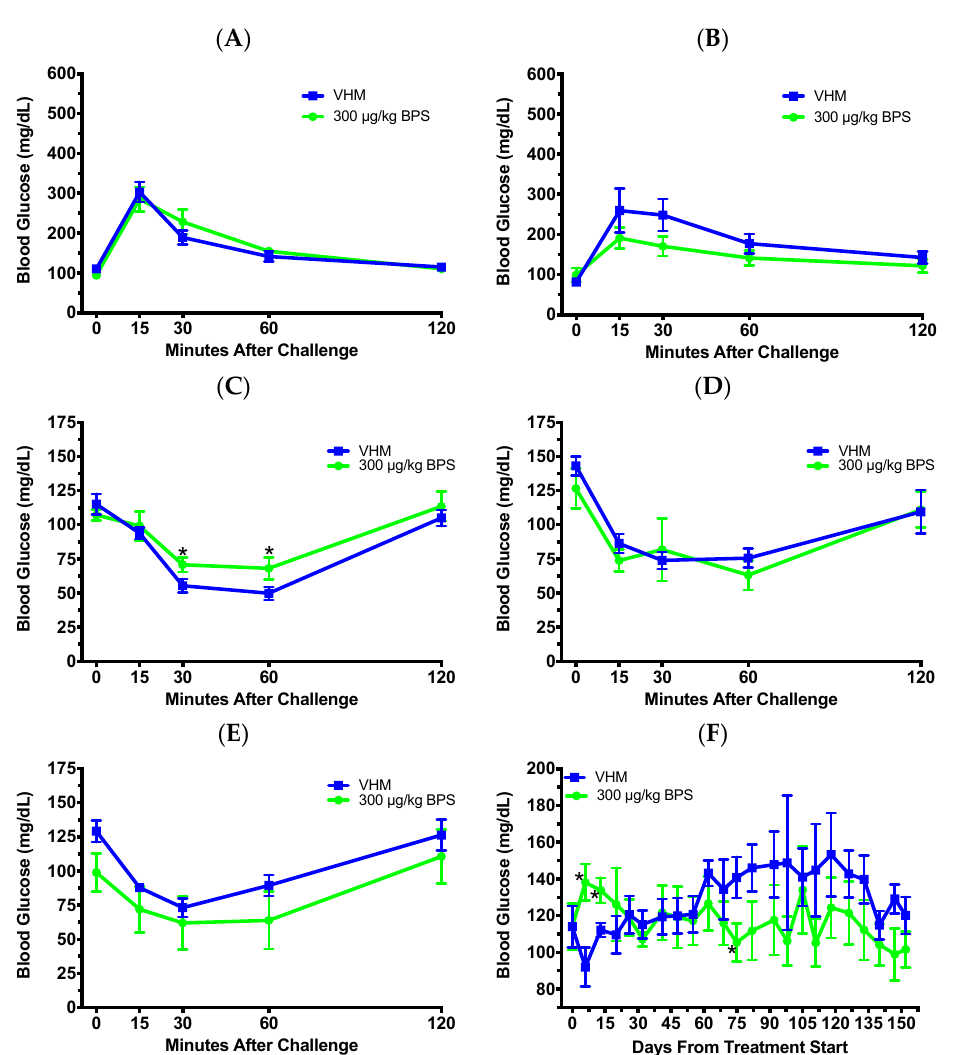
Figure 3. Tolerance tests and blood glucose levels (BGLs) in male NOD mice on the soy-based diet. GTT after 1 month ( A ) and 2 months ( B ) of BPS exposure, and ITT after 1 month ( C ), 2 months ( D ) and 5 months ( E ) of BPS exposure are shown. ( F ) Time course of non-fasting BGLs. The values are presented as mean ± SEM. *, p < 0.05. N = 5–6. VHM, vehicle males. Table 2. Percentages of splenic immune cell populations in male NOD mice on the soy-based diet. Antibody Combinations